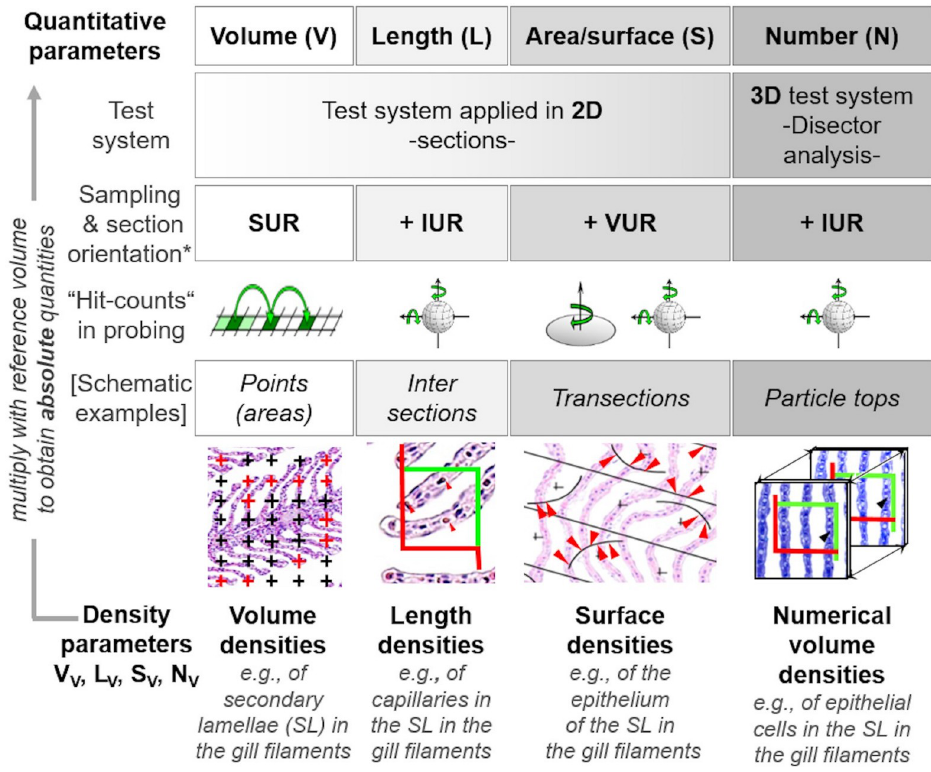
Fig 1. Quantitative parameters, stereological test systems, sampling, section orientation and stereological probes in quantitative stereological analyses. Volume densities (V V(structure of interest/reference space) ), length densities (L V (structure of interest/reference space) ) and surface area densities (S V(structure of interest/reference space) ) are estimated in representative, systematically uniform random (SUR) sampled 2-D sections of the reference space. Volume densities are deduced from the fractional areas of the structure of interest and the reference space, determined e . g ., by point counting. Length densities are estimated on isotropic uniform random (IUR) sections from the number of intersections of the structure of interest with the section area. ( Note that the present guidelines do not cover quantitative stereological estimation of length parameters of gill structures . Determination of the true harmonic mean of the diffusion barrier thickness in the secondary lamellae (SL) is described in Section 15 .) For estimation of surface area densities, the number of interactions of the examined surface area with appropriate stereological probes is counted in vertical uniform random (VUR) sections. Estimation of numerical volume densities (N V(structure of interest/reference space) ) requires 3-D test systems, such as the physical disector, to sample and count particles. A physical disector is a stereological probe used for unbiased counting and sampling of particles. It consists of two parallel histological sections (a reference section and a look-up section) with a defined distance, thus defining a known tissue volume. Particles that are sectioned in the reference section, but not in the look-up section are counted (Q - ), using the unbiased counting frame. Estimation of N V(structure of interest/reference space) using the physical disector is described in detail in Section 14 . Absolute quantities of volumes, lengths, surfaces and numbers are obtained from the respective densities and the total reference space volume. Mean particle volumes are calculated from their volume densities and their numerical volume densities in the reference space, as described in Section 14 . � The section plane orientation illustrated for the corresponding parameters is highly recommended, but there are several options for most morphological parameters regarding the orientation of the section